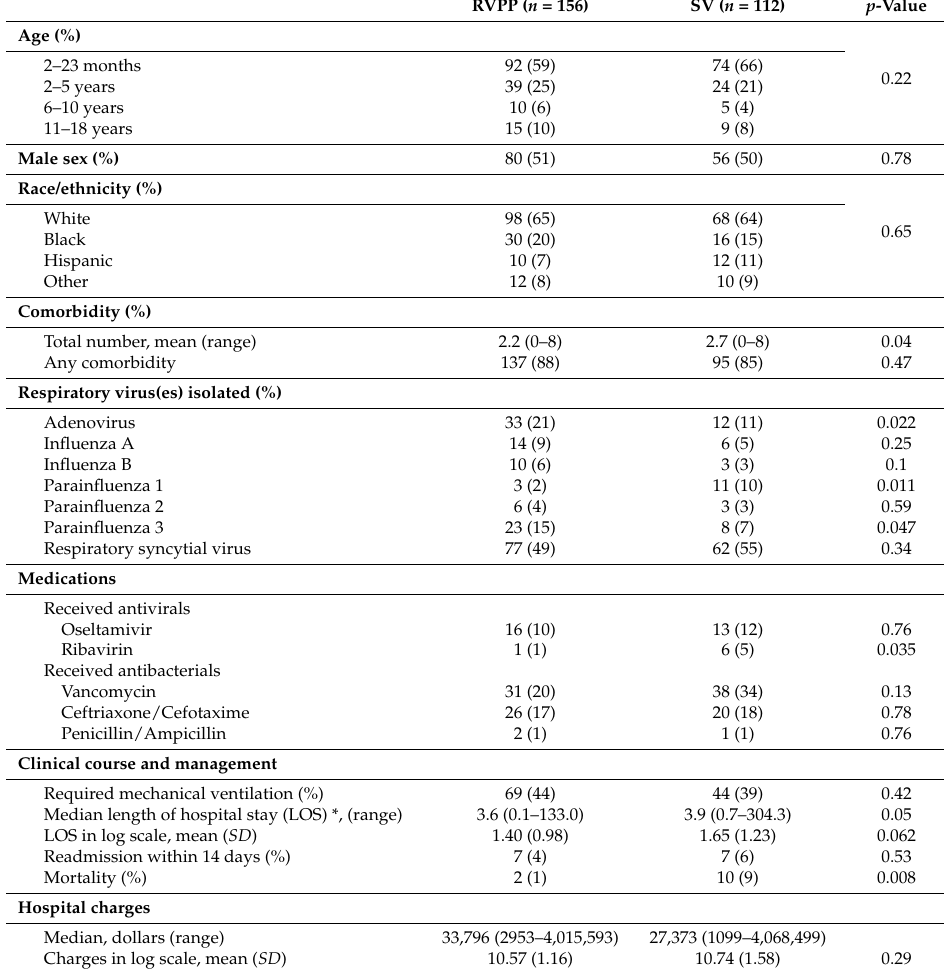
Table 2. Characteristics and comparison of the two study populations, excluding HRV and hMPV. RVPP ( n = 156) SV ( n = 112) p